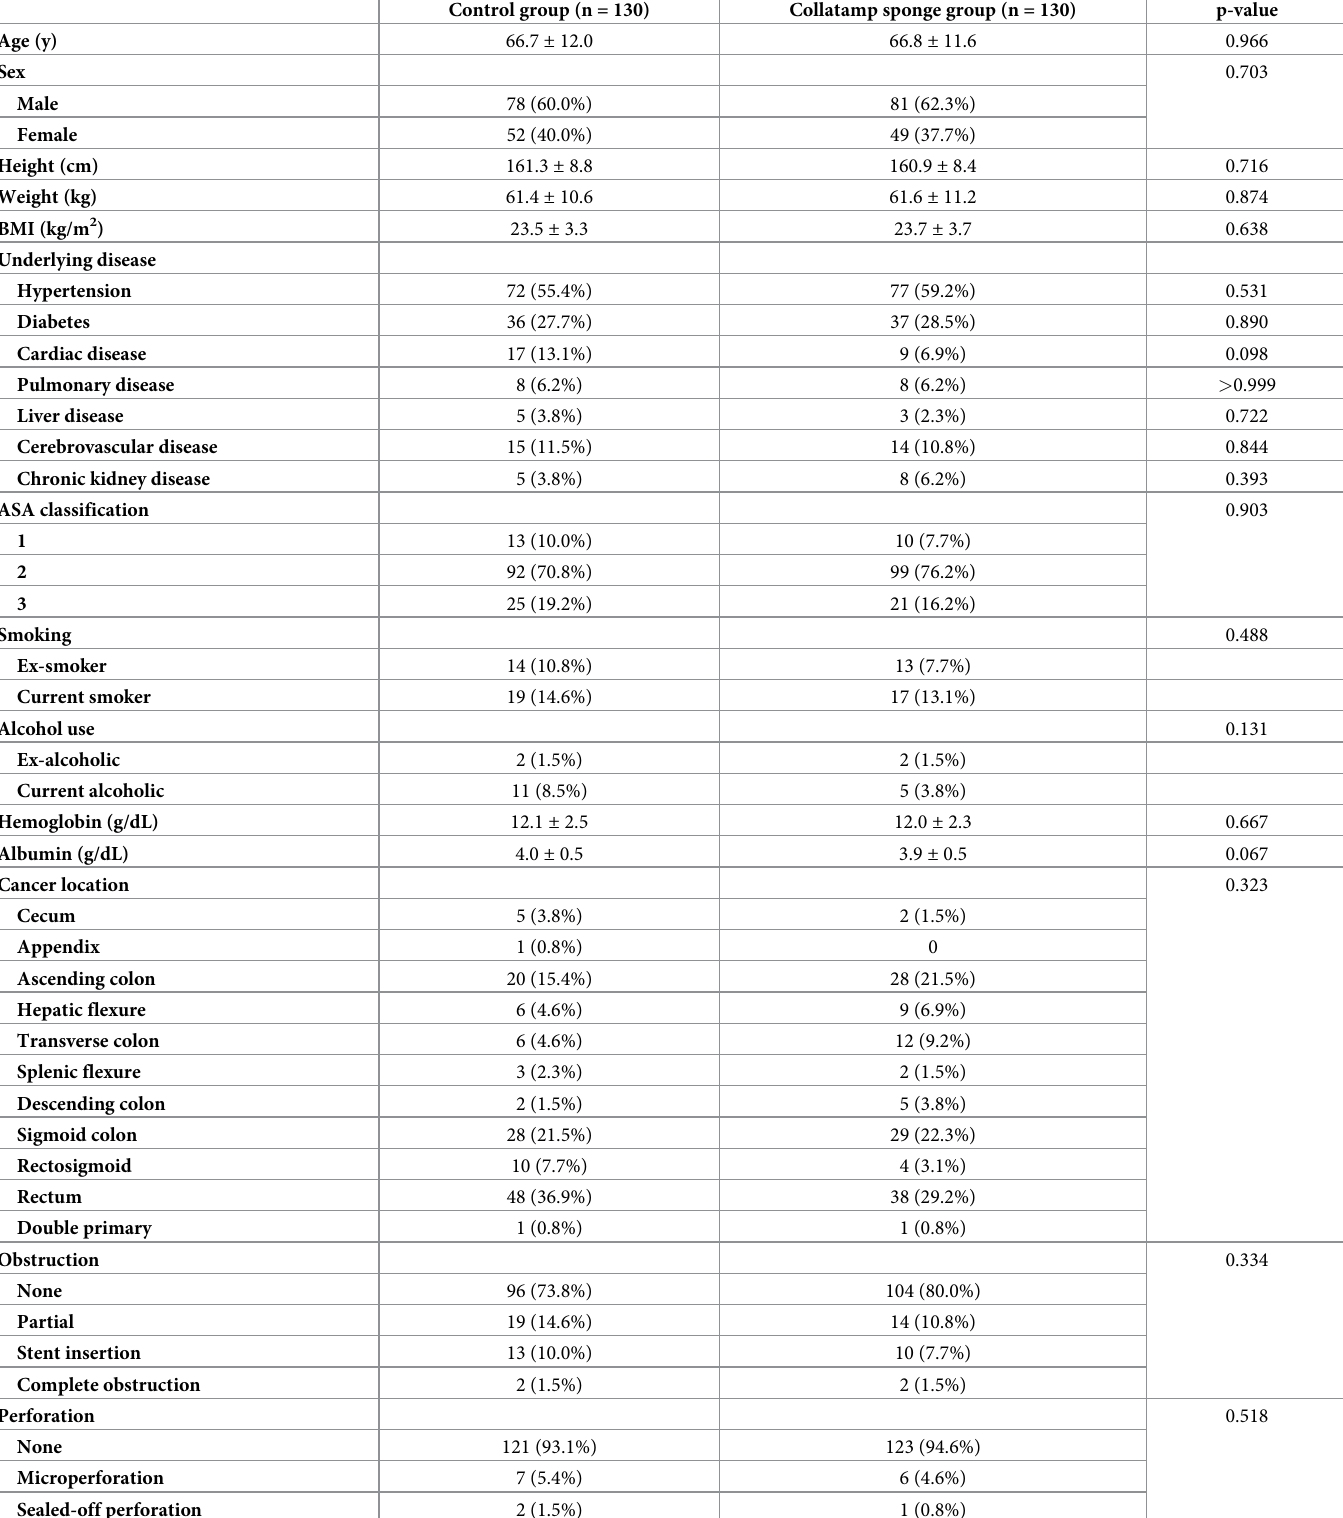
Table 2. Patients’ characteristics after propensity score